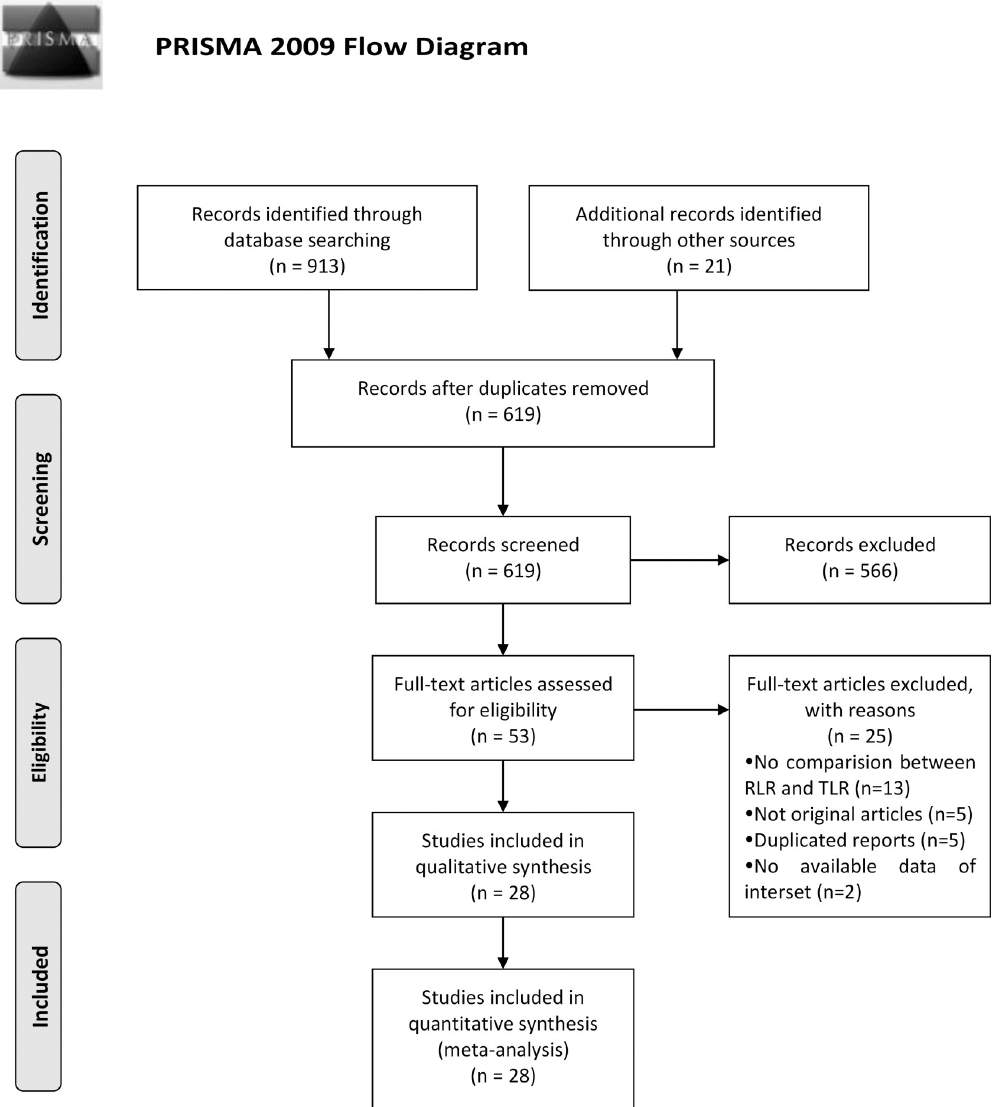
Fig 1. Flow diagram of studies identified, included, and